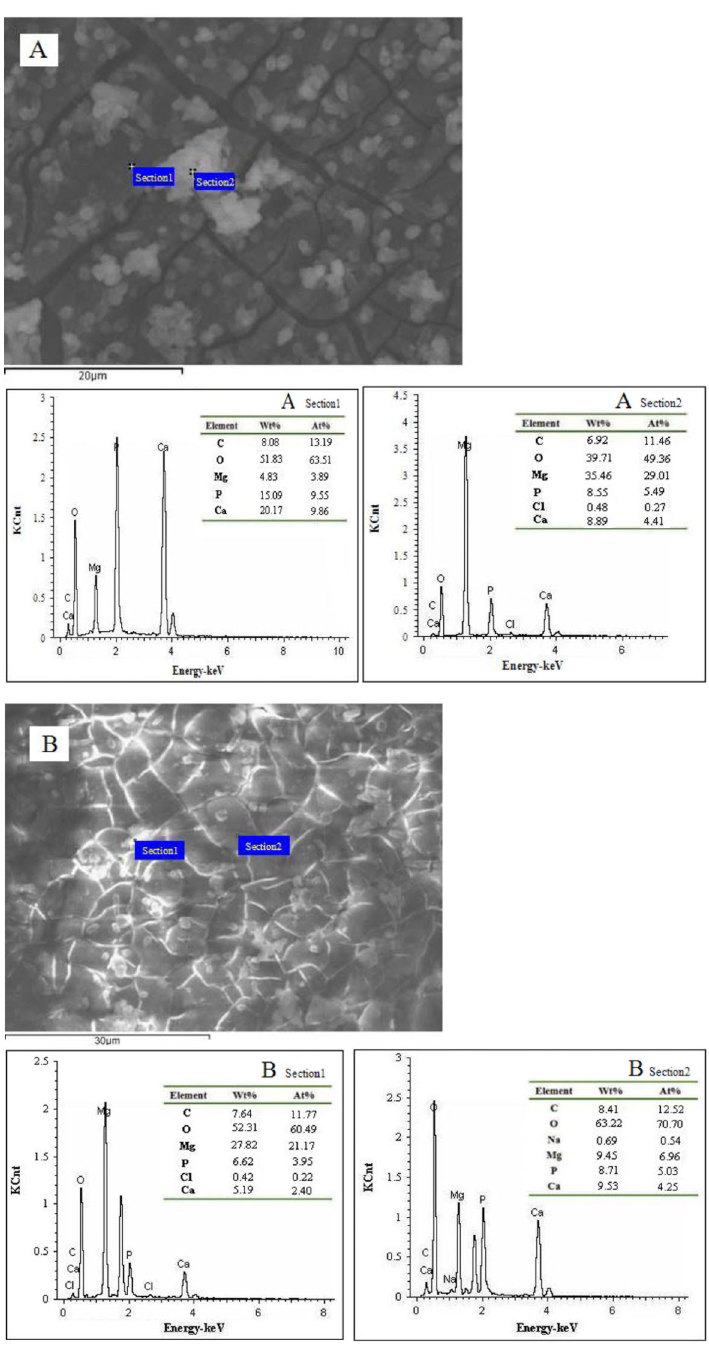
Figure 3. Energy dispersive spectrometry of the corrosion products of untreated Mg ( A ),